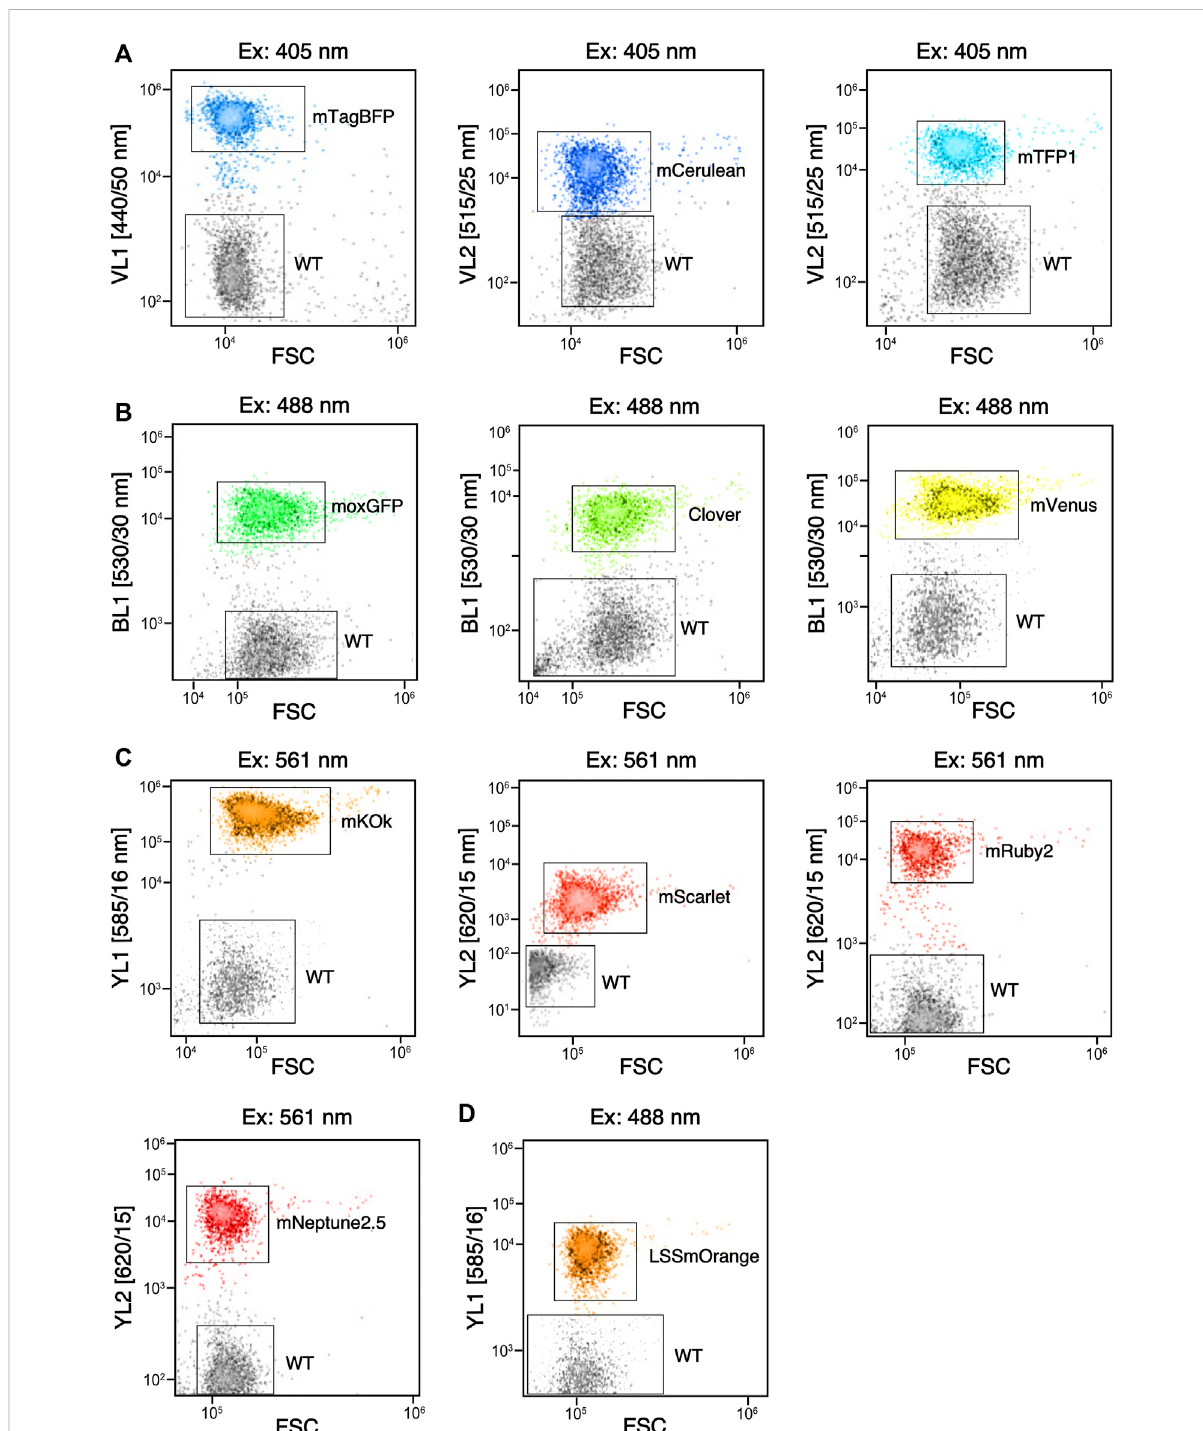
FIGURE 5 Flow cytometry of fl uorophores expressed in C. reinhardtii that can be separated from wild type (WT). (A) signals obtained for three reporters compared to WT with violet laser (405 nm) excitation and emission against forward scatter (FSC) plot from respective fi lters (VL#). (B) signals obtained from three reporters compared to WT with blue laser (488 nm) excitation and emission from the BL1 fi lter plotted against FSC. (C) Signals obtainedfrom4reporterscomparedtoWTwithorangelaser(561 nm)excitationandemissionfromvarious fi lters(YL#)plottedagainstFSC. (D) Signal of LSSmOrange compared to WT when stimulated with 488 nm laser and visualized with YL1 emission plotted against